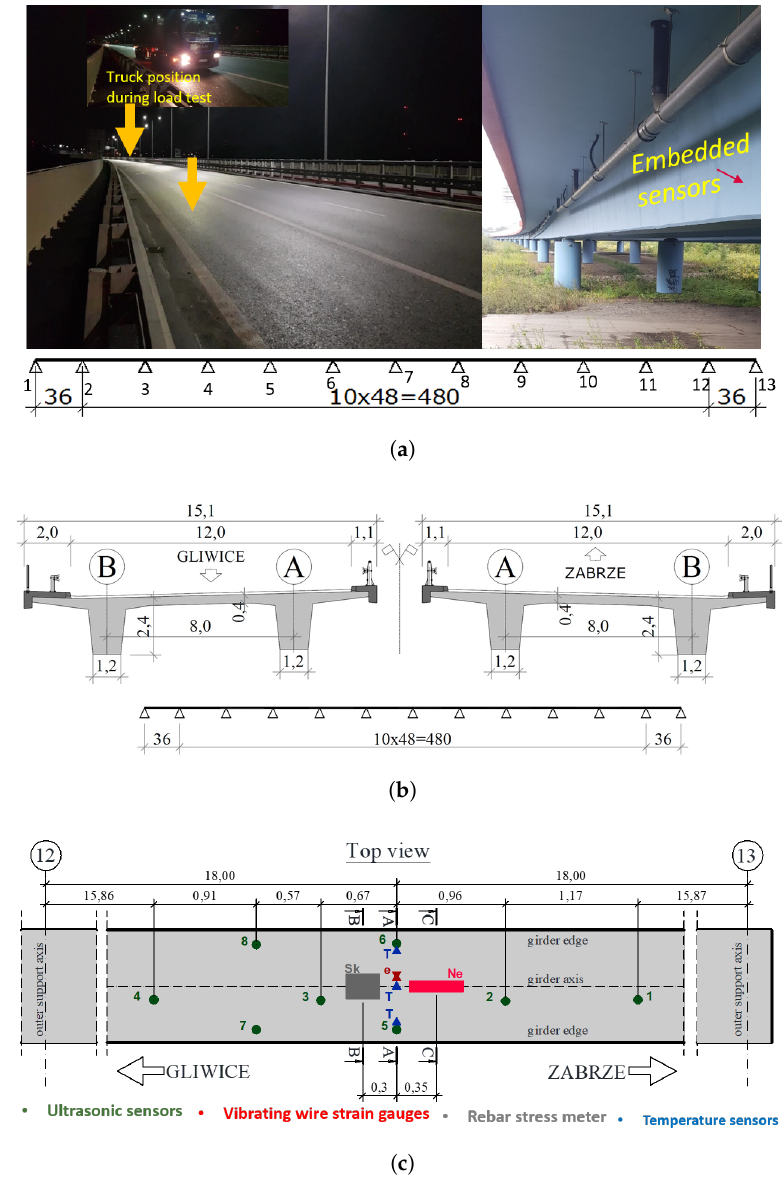
Figure 4. The static scheme and arrangement of all sensors. ( a ) Bridge in Gliwice; ( b ) Static scheme and cross-section of the bridge in Gliwice; ( c ) Arrangement of all sensors in the